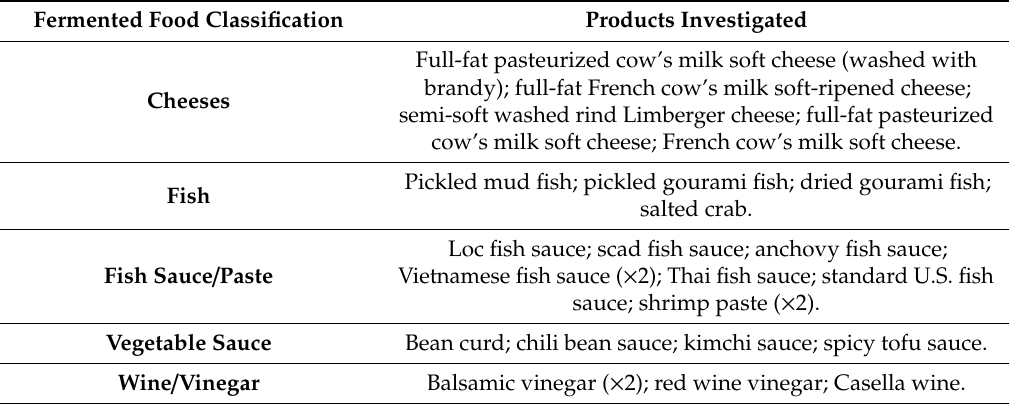
Table 1. Details of fermented food products investigated for each